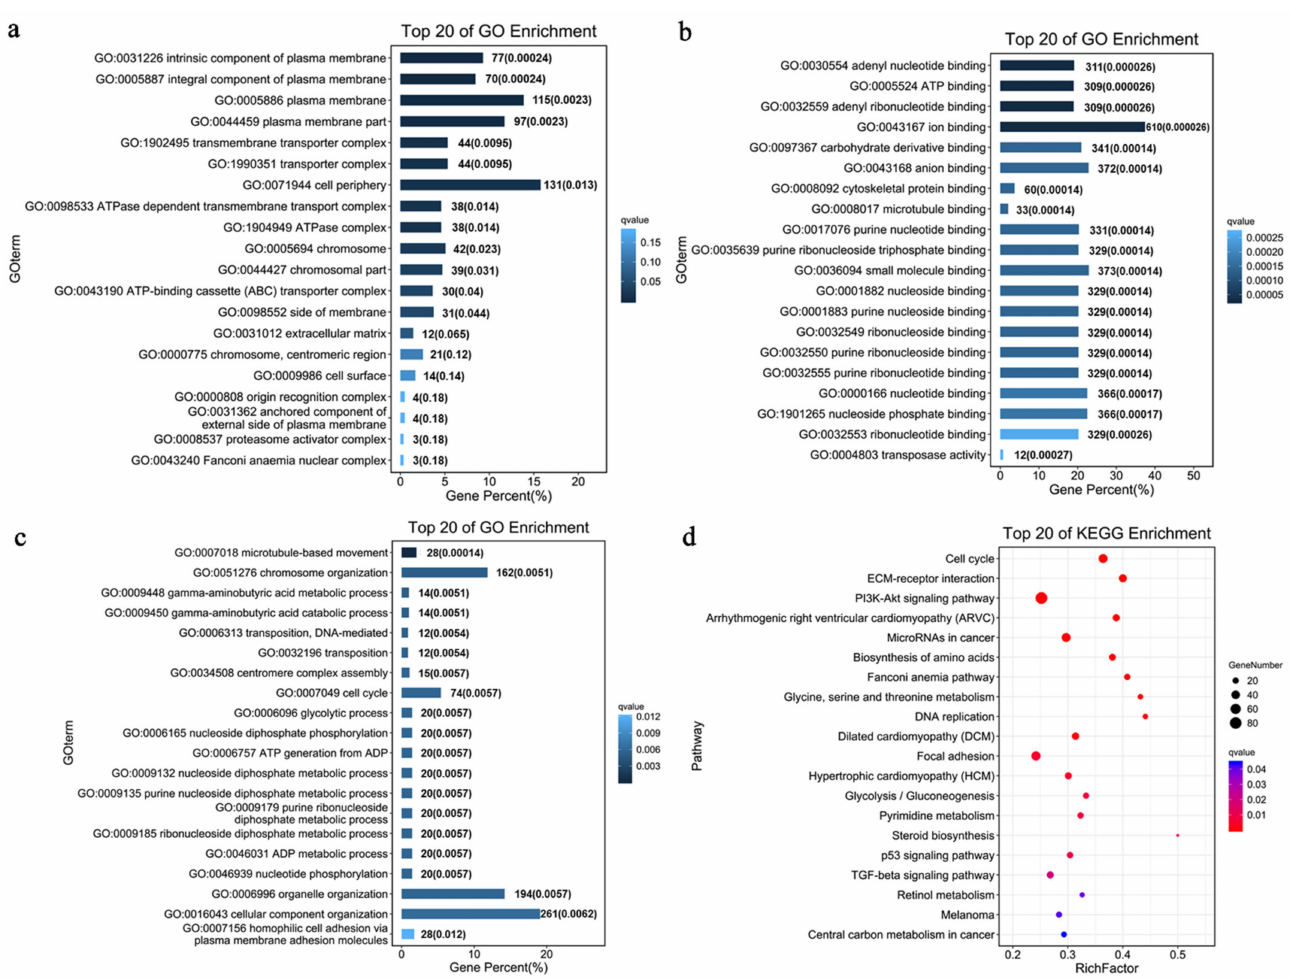
Figure 7. GO and KEGG enrichment of DEGs in transcriptome sequencing analysis. GO enrich- ment analysis of DEGs in ( a ) cellular component, ( b ) molecular function, and ( c ) biological process. ( d ) KEGG pathway enrichment analysis of enriched